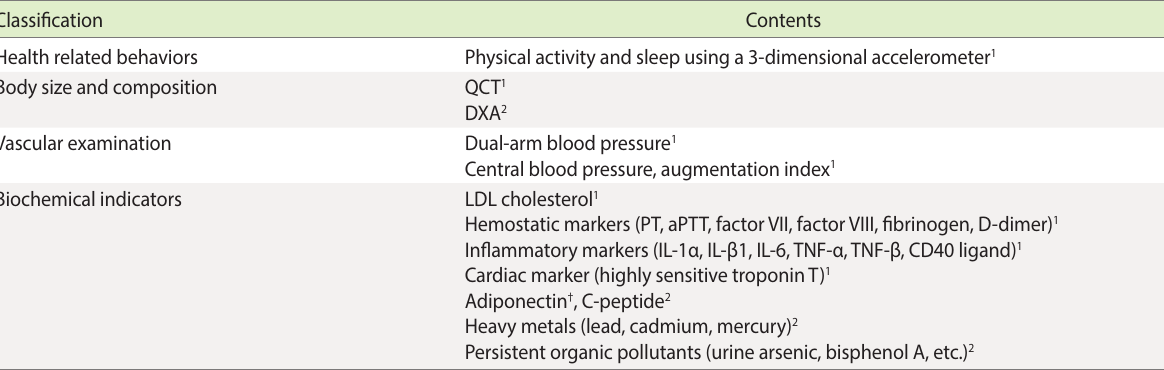
Table 4. Site-specific elements of the baseline assessment